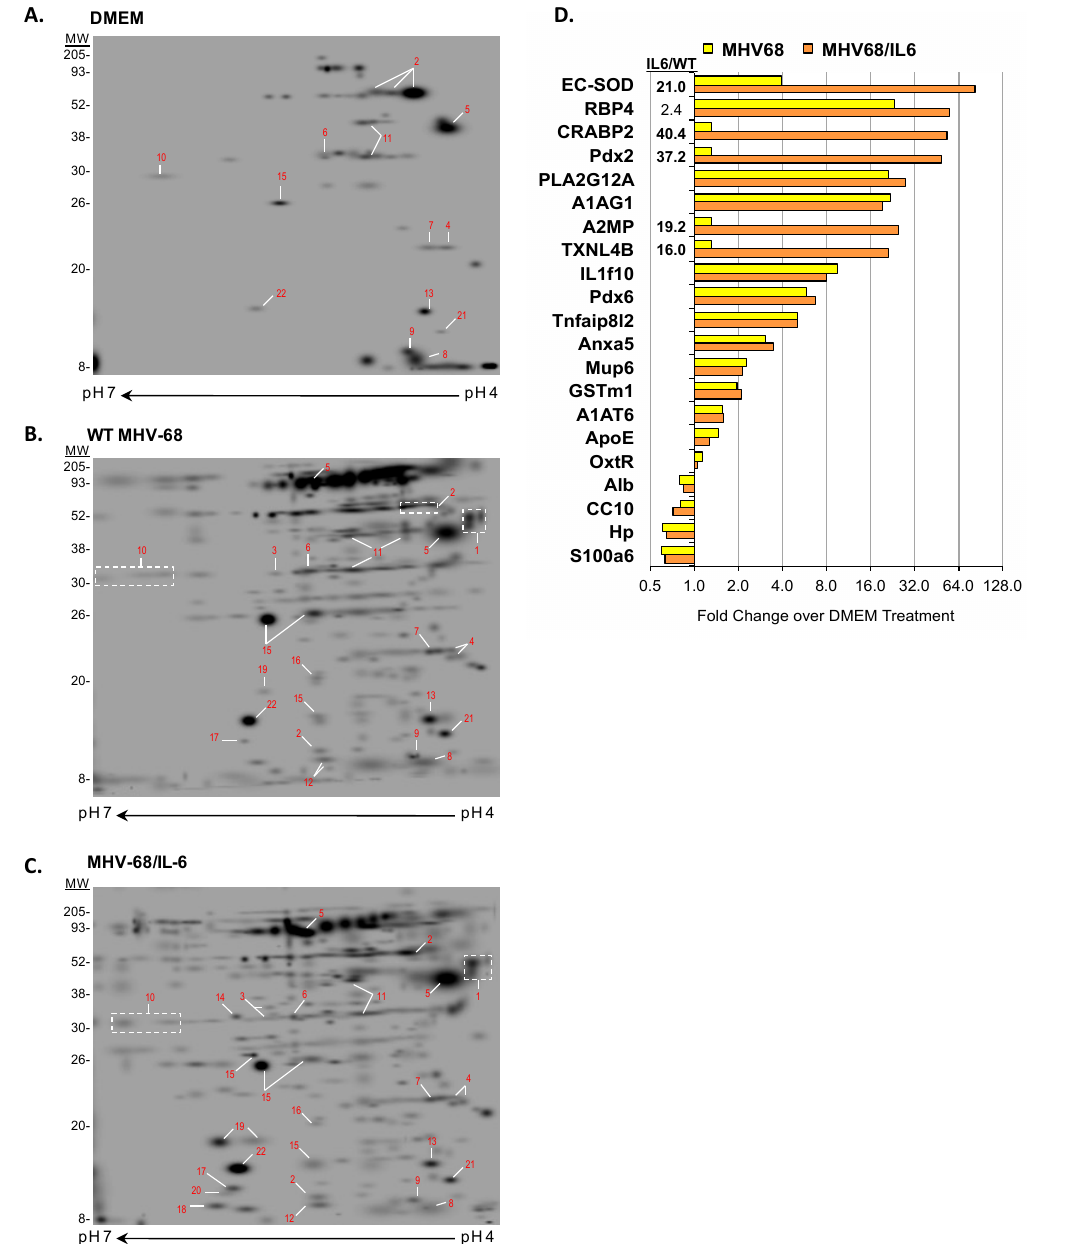
Figure 2. Enriched BAL proteome from mice infected with MHV-68 viruses. Mice were intranasally (i.n.) inoculated with DMEM ( A ), or infected i.n. with 5 × 10 5 pfu of WT MHV-68 ( B ) or MHV68/IL6 virus ( C ). BAL was collected from mouse lungs 9 d.p.i., pooled, and processed to enrich for less abundant proteins as described in Methods. Eluted BAL proteins were separated by isoelectric focusing followed by 2D-PAGE and SYPRO-Ruby staining. Proteins resolved in the pH 4–7 range were sufficiently separated for spot identification ( red numbers ), excision, and tryptic digestion for protein identification by MALDI and/or LC/MS-MS. Spots were quantified by densitometry, normalized as described in Methods, and fold induction over orthologous spots in mock (DMEM) treatment is indicated ( D ). Significant fold induction (>2.0) of MHV68/IL6 over WT MHV-68